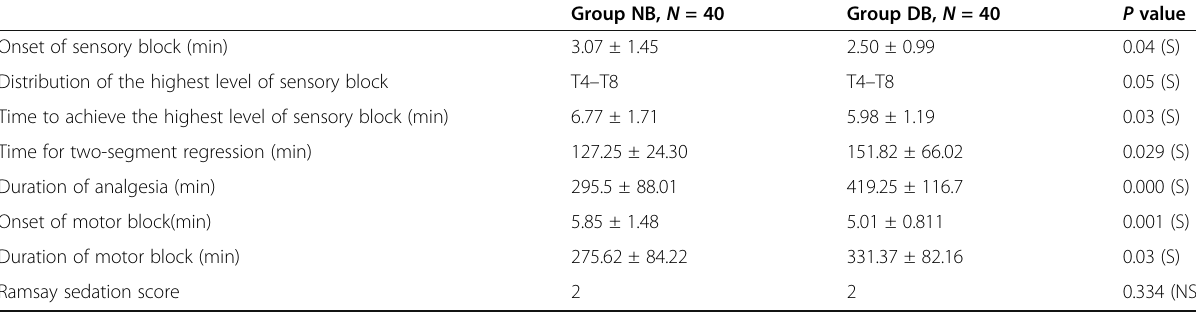
Table 2 Characteristics of subarachanoid